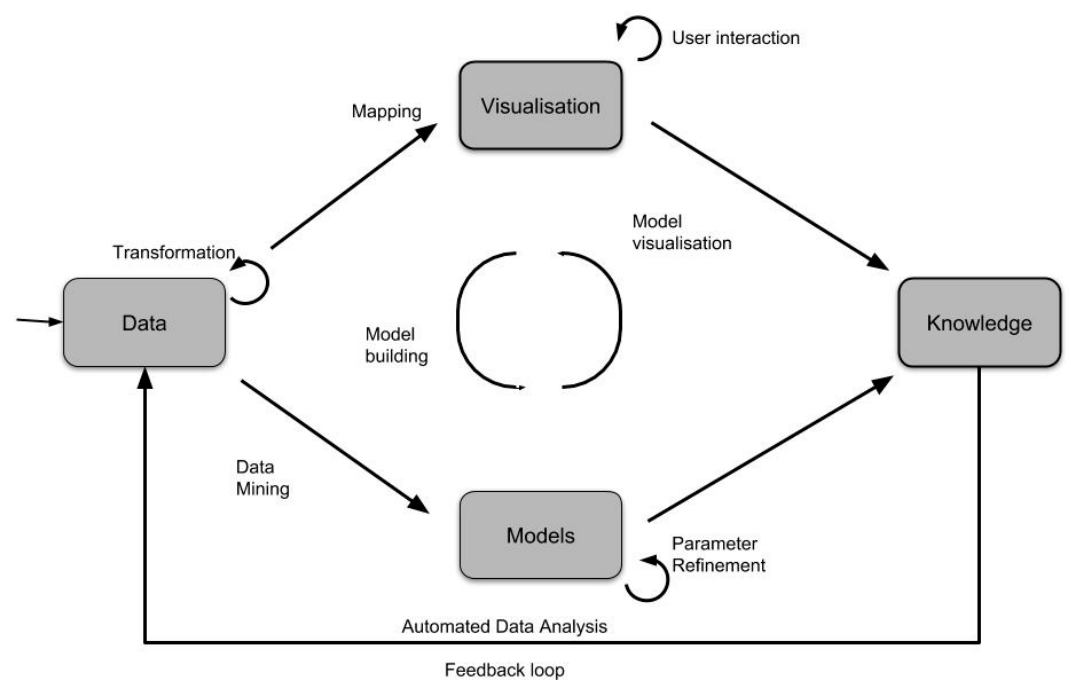
Figure 1. An adaptation of the visual analytics process by Kiem [7].